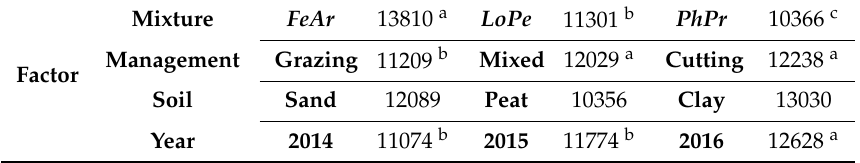
Table 3. Dry matter yields (Lsmeans, in kg DM ha − 1 ) for the main factors mixture, management, soil, and year. * Small letters indicate significant differences between the year and the management within one species. FeAr: Festuca arundinacea , LoPe: Lolium perenne , PhPr: Phleum pratense .